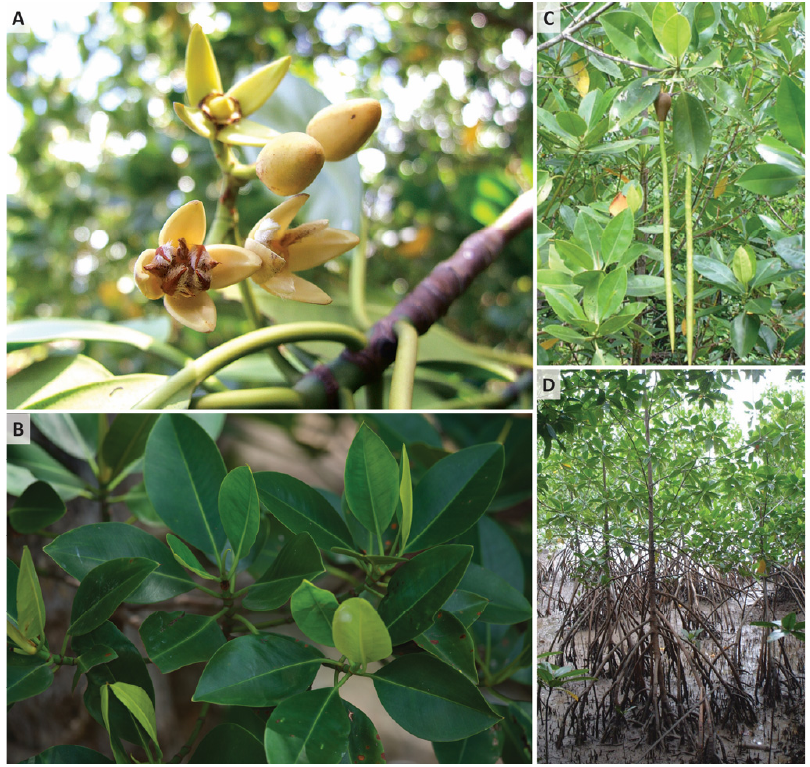
Figure 1. Morphology of R. mucronata in Thailand. ( A ) Flower. ( B ) Leaves. ( C ) Fruits. ( D ) Aerial root. Pictures taken by Wasitthee Kongkachana on 26 October 2020.